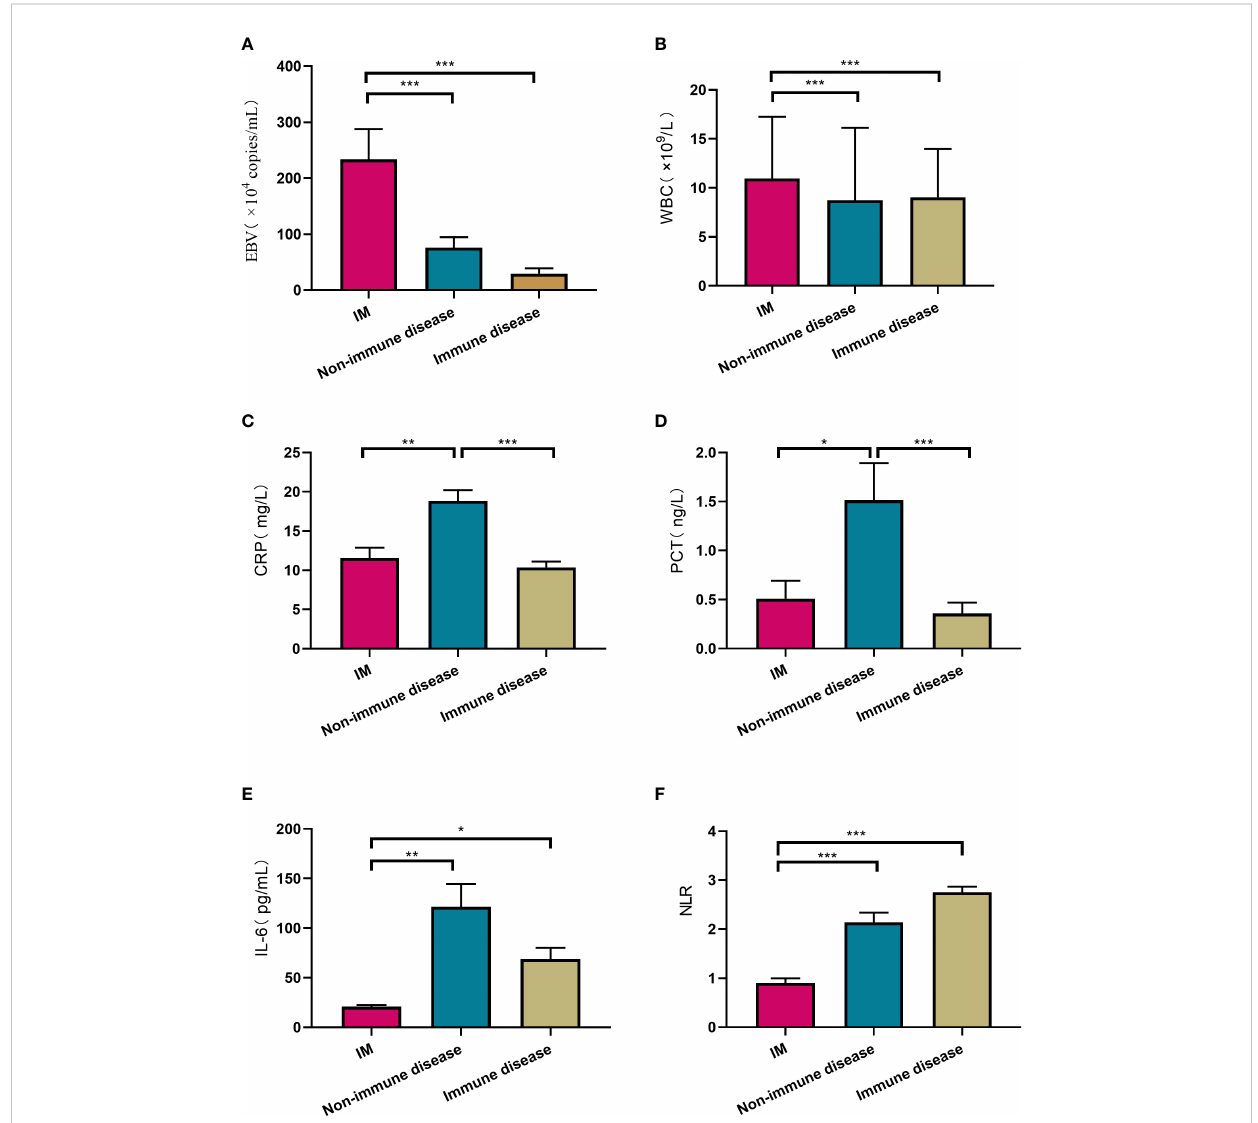
FIGURE 5 Comparison of laboratory testing results among IM, non-immune diseases and immune diseases. Laboratory testing included EBV viral loads (A) , WBC (B) , CRP (C) , PCT (D) , IL-6 (E) , NLR (F) . *P<0.05, **p<0.01, ***p<0.001. White blood cell counts (WBC), C-reactive protein (CRP), Procalcitonin (PCT), Interleukin-6 (IL-6), Neutrophil/lymphocyte ratios